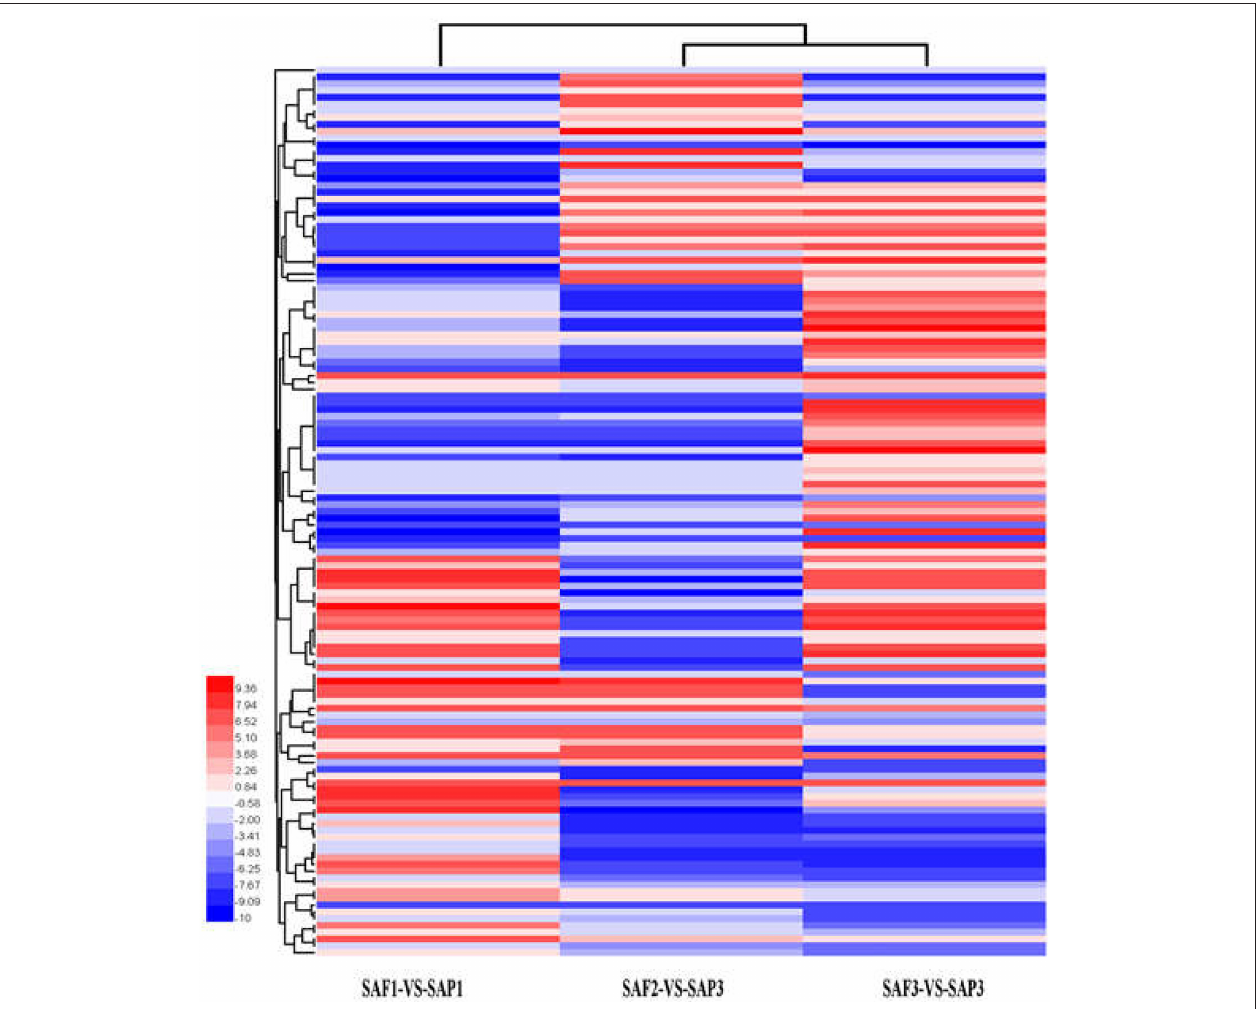
FIGURE 5 | Hierarchical clustering (HCE) analysis of differentially expressed transcripts between stem apex of primocane and floricane at three developmental stages (SAP1-VS-SAF1, SAP2-VS-SAF2, and SAP3-VS-SAF3, “a” was the control and “b” was experimental group in “a-VS-b”). The clusters from A to H indicate the eight major clusters resulting from HCE analysis. Each line refers to data from one gene. The color bar represents the log 10 RPKM and ranges from blue (low expression) to red (high expression).